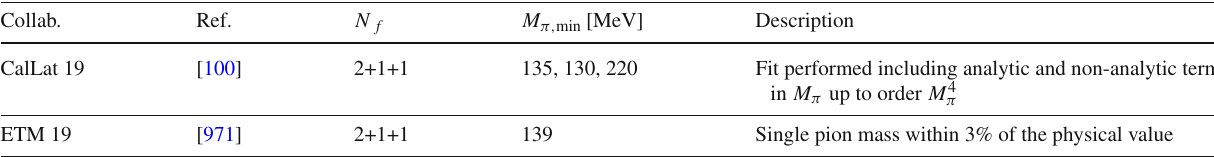
Table 176 Chiral extrapolation/minimum pion mass in determinations of the isovector axial, scalar and tensor charges with N f = 2 + 1 + 1 quark flavours Collab.